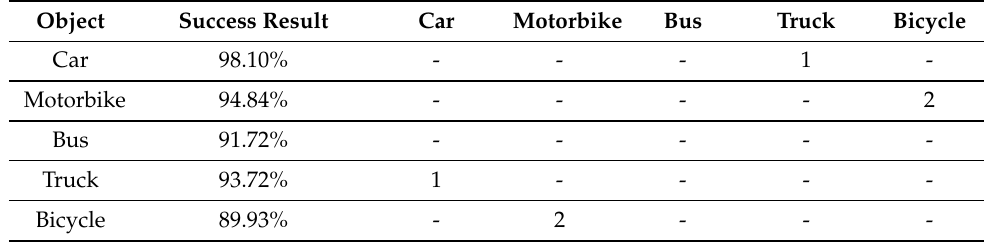
Figure 7. Projected bounding box loss, a cell holding an item, and the model’s class loss. Table 2. Classification performance